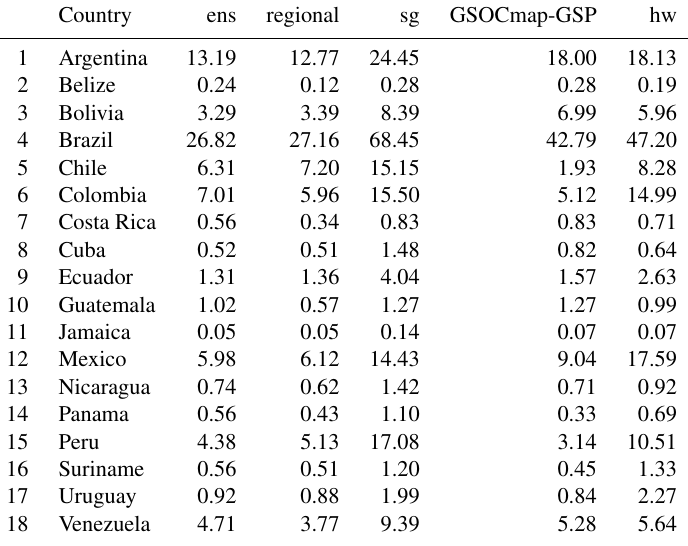
Table 3. SOC stocks (Pg) at the contextual resolution of 5 × 5km grids. The terms used are defined as follows: ens is country-specific, regional is Latin America ensemble, sg is the SoilGrids system, GSOCmap-GSP is country-specific 1km, and hw is the Harmonized World Soil